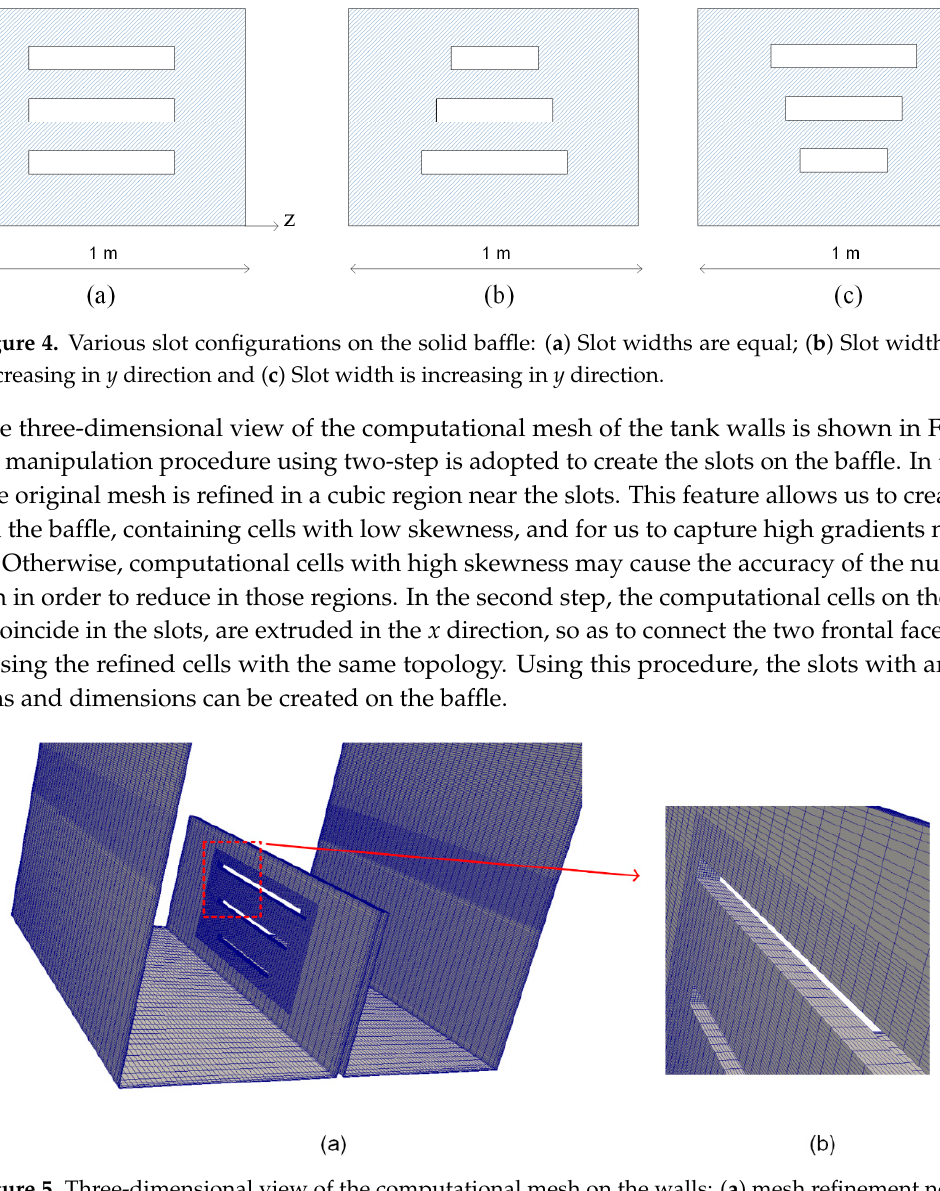
Figure 5. Three-dimensional view of the computational mesh on the walls: ( a ) mesh refinement near the slots and ( b ) close-up view of the refined region near the slots.